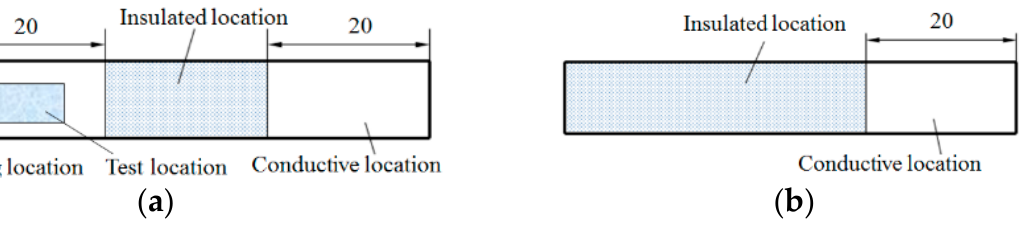
Figure 1. Schematic diagram of the matrix size of the substrate and the sealing, plating and conductive locations: ( a ) front view and ( b ) back-face view.